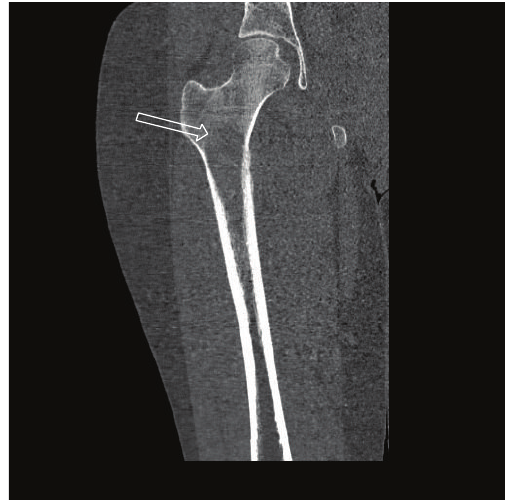
Figure 3: Coronal CT reformation of the right proximal femur reveals subtle low-attenuating lesion without cortical destruction or soft-tissue component. The arrow points to the superior margin of the ill-defined lesion.